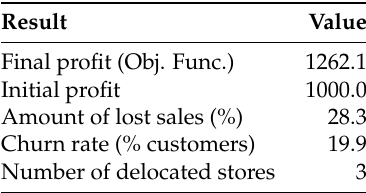
Table 2. Results of the case study.